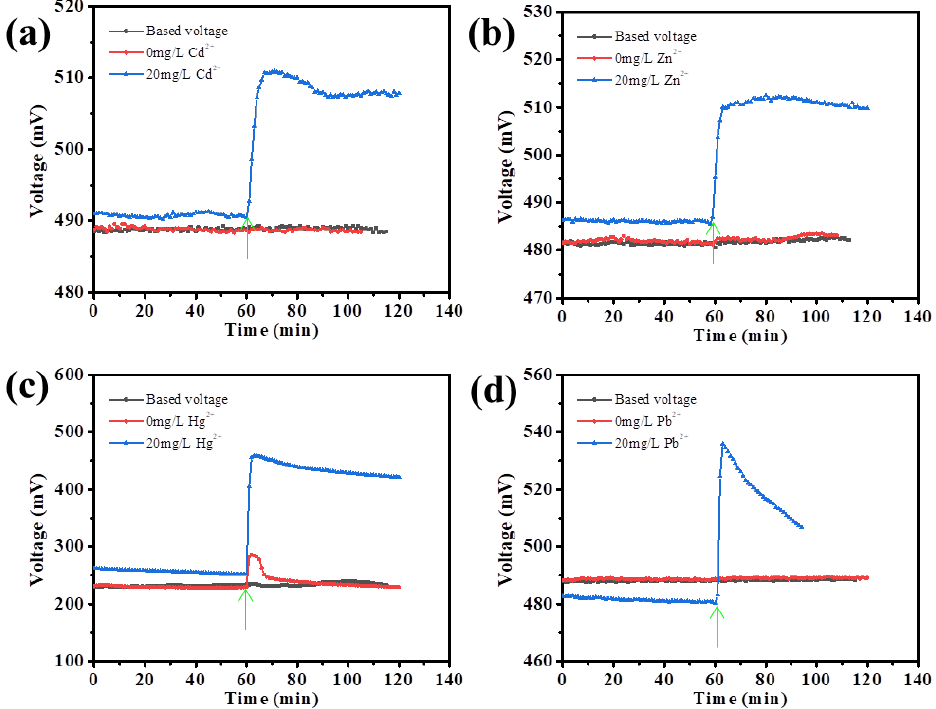
Figure 3. The response of the SMFC voltage output to the addition of Cd 2+ ( a ), Zn 2+ ( b ), Hg 2+ ( c ), or Pb 2+ ( d ). The green arrow indicates the injection of the heavy metal ions.